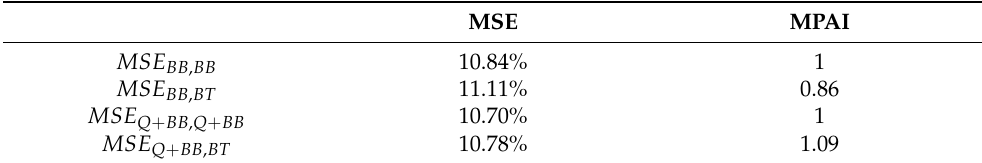
Table 5. MSE and MPAI results of case study